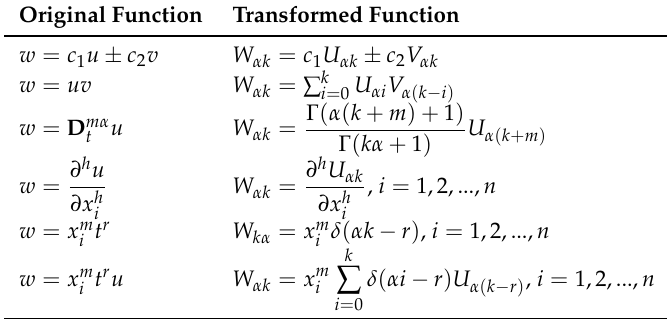
Table 1. Fundamental operations of the fractional reduced differential transform method (FRDTM) [14,16,27]. Original